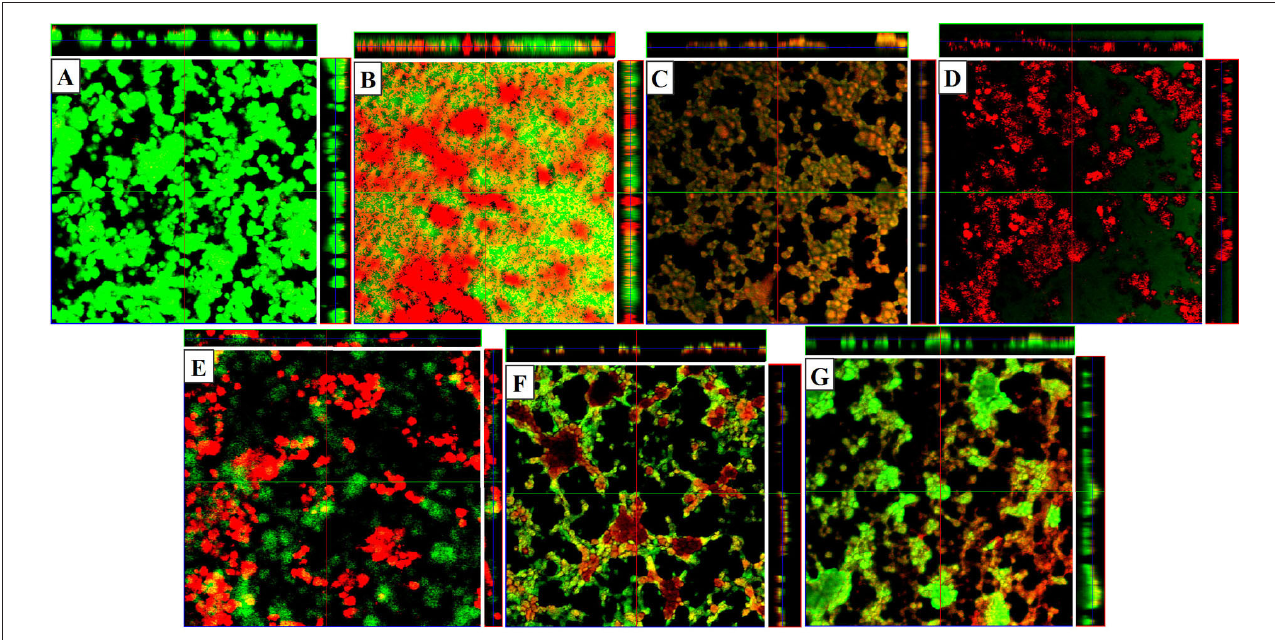
Fig. 1: Confocal Laser Scanning Microscopy of biofilms treated with saline (A) after treatment with mouthwashes containing 70% ethanol (B) essential oils (C), 0.2% chlorhexidine (D), 0.12% chlorhexidine plus alcohol (E), 0.12% chlorhexidine without alcohol (F) and alcohol-free cetylpyridinium chloride plus fluoride (G). All images show a three-dimensional reconstruction rotated 90º in the y-z direction (above) and in the x-z direction (right